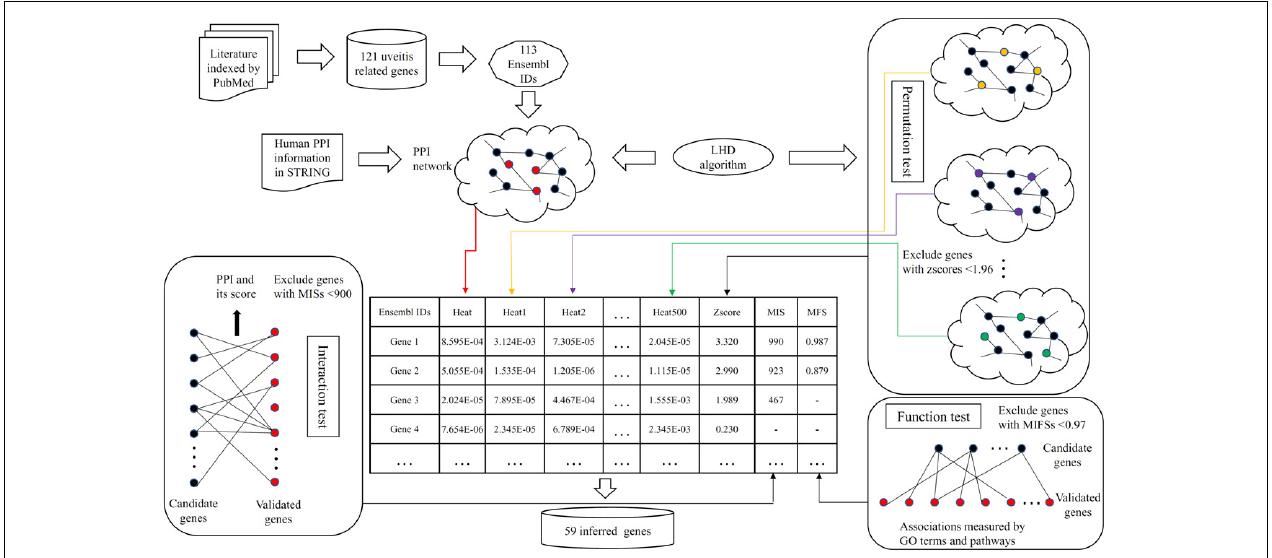
FIGURE 1 | Flow chart showing the detailed procedures of the computational method for inferring novel uveitis-related genes. Ensembl IDs of uveitis-related genes were used as the seed nodes of Laplacian heat diffusion (LHD) algorithm, resulting in a heat value for each gene in the PPI network. In the permutation test, the LHD algorithm was executed 500 times with different seed nodes, yielding 500 heat values for each gene. Then, a zscore (cf. equation 2) of each gene was calculated and those with zscores less than 1.96 were discarded. The interaction test assessed each candidate gene by checking its associations to validated genes and excluded candidate genes with MISs (cf. equation 3) less than 900. Finally, the remaining genes were evaluated in the function test, which measured candidate genes by investigating their linkages based on gene ontology (GO) terms and biological pathways. Candidate genes with MFSs (cf. equation 5) less than 0.97 were discarded. Fifty-nine inferred genes were